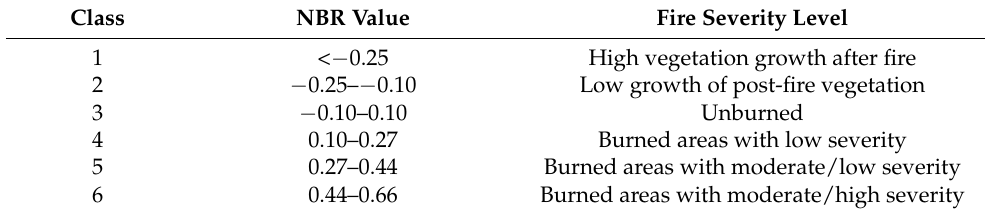
Table 4. NBR classification. Source: adapted from